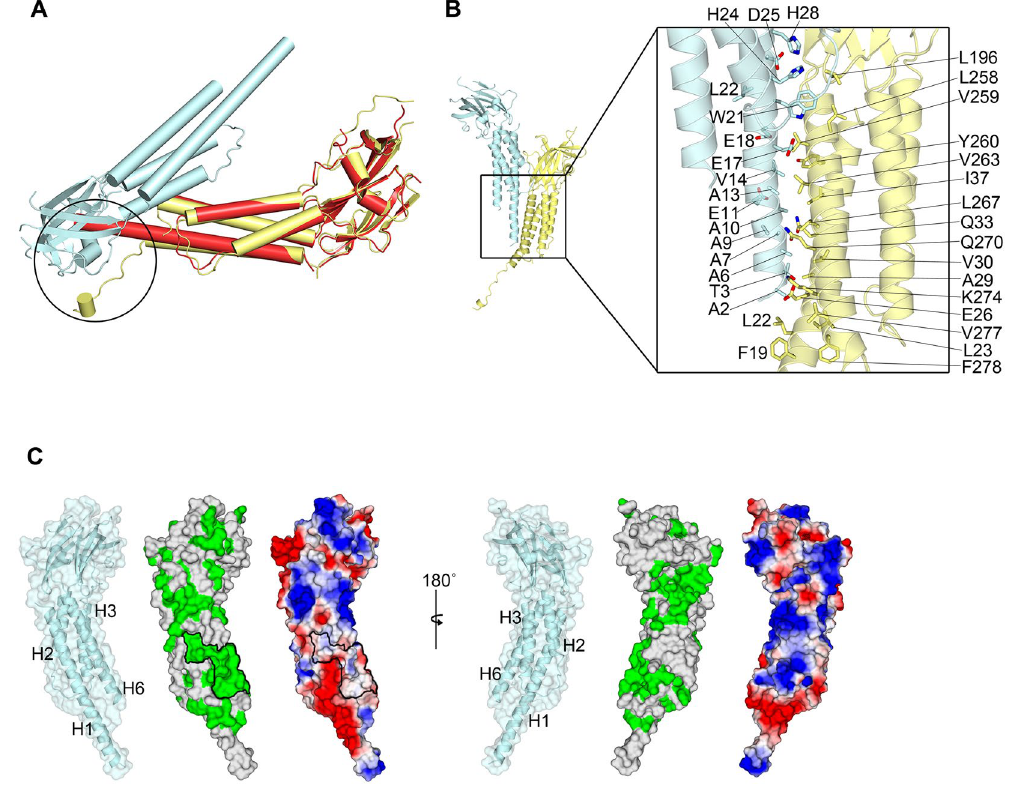
Figure 4. Extended H1 and H6 Helices Mediate Protein–Protein Interactions. ( A ) Crystal contacts of Rogdi L in the asymmetric unit. Circles indicate the flexible N-terminal helix of Rogdi L , which is bent sharply due to steric hindrance. The structure of Rogdi H (red) is overlaid with that of Rogdi L (yellow) for structural comparison and to highlight steric hindrance between molecules in the crystal asymmetric unit. ( B ) Rogdi molecules showing crystal contacts (left). The close-up view on the right shows residues that contribute to contact surfaces. Oxygen and nitrogen atoms are colored red and blue, respectively. ( C ) Surface representation of Rogdi H . The surface is colored according to residue identity (middle) as shown in Fig. 1B, and according to charge distribution (right), highlighting the conservation of hydrophobic residues that might be involved in protein–protein